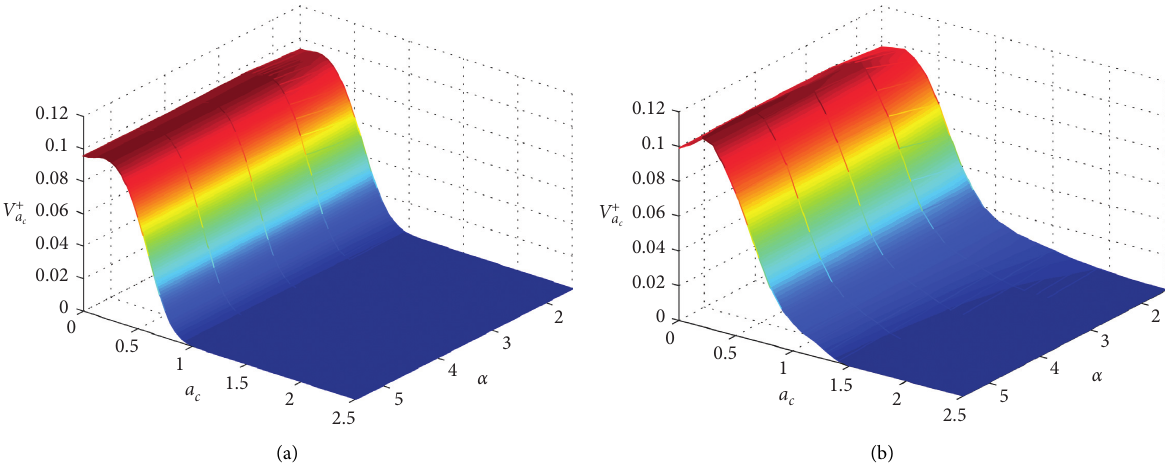
a c and fractional order α (